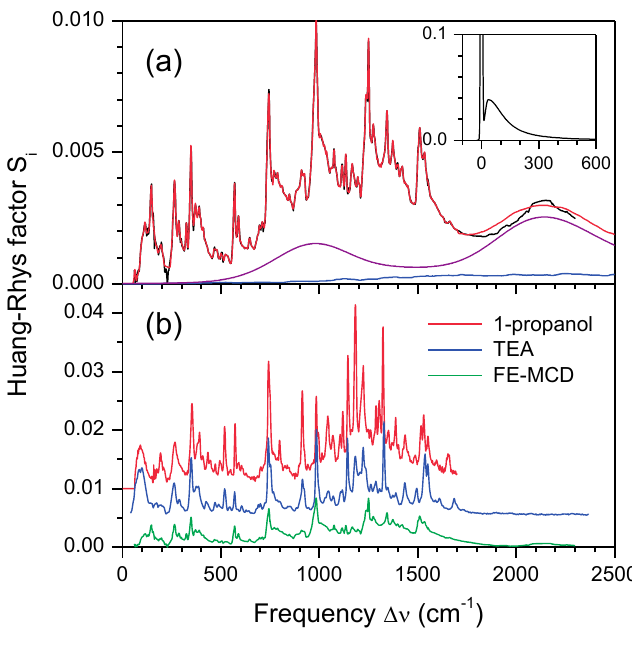
Fig. 8. (a) The normalized high-resolution fluorescence excitation spectrum of Chl-a in wet ether at 4.2 K [42] (black) and its interpretation (red). The fitting curve is evaluated as a sum of a low-resolution x -polarized component (purple, obtained self- consistently along with the MCD spectral fit) and a 236-mode Huang–Rhys component with the assumed ZPL and PSB spectral shape (inset). The blue curve shows the contribution of multiple excitations to the Huang–Rhys spectrum [63]. (b) Comparison of the Chl-a mode structures in 1-propanol (red) and TEA (blue) related to the Q transition, as observed at 4.5 K by Δ FLN, with the y y -polarized fluorescence excitation profile obtained by subtraction of the purple x -polarized component from the black experimental fluorescence excitation spectrum, as shown in panel (a). For better visibility, the three curves are vertically shifted relative to each other by 0.005 units. For both (a) and (b), the y- scale is such that the value of the Huang–Rhys factor for a vibrational fundamental that is not overlapped by other peaks is given by the peak